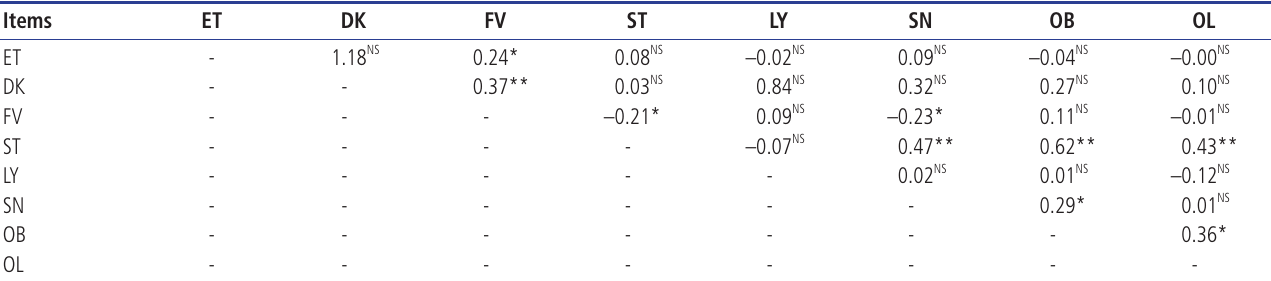
ET, time spent eating; DK, time spent drinking; FV, number of feeder visit; ST, time spent standing; LY, time spent lying down; SN, time spent sniffing; OB, time spent biting objects; OL, time spent licking objects.